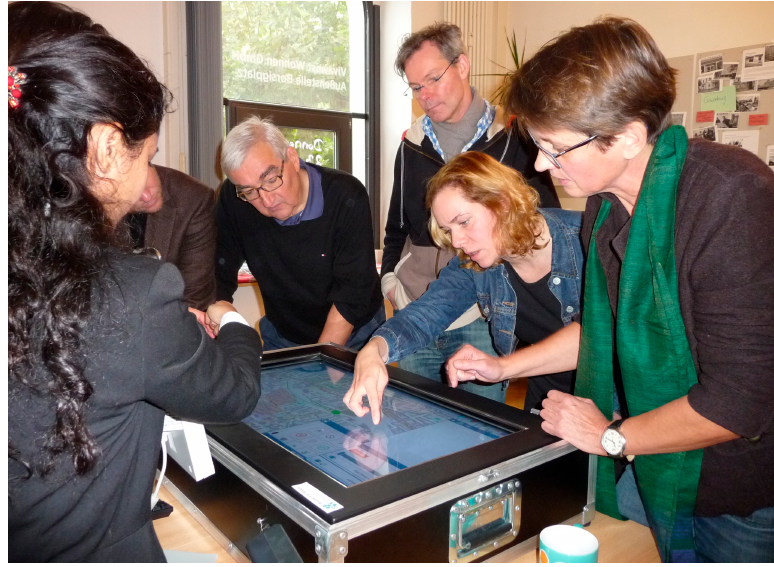
Figure 1. Stakeholders collaborating on a maptable (Source J. Flacke).